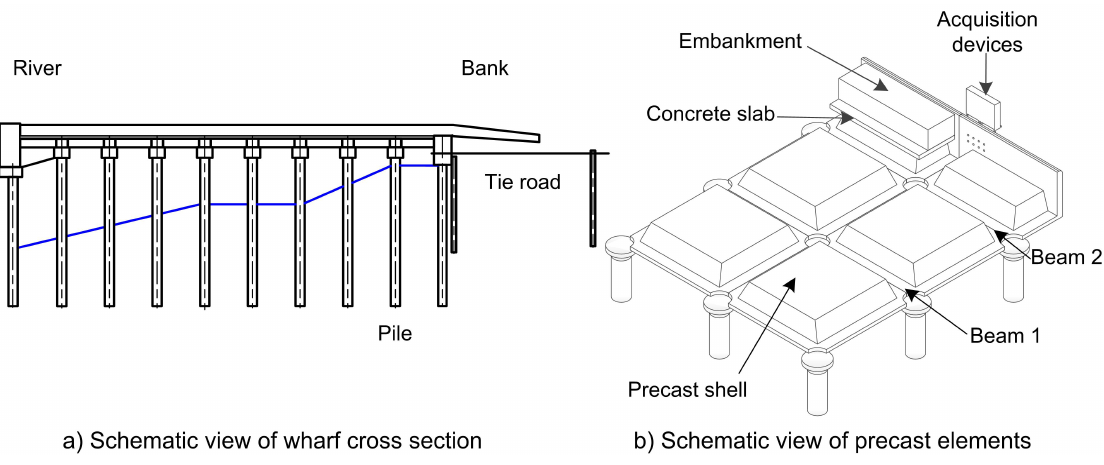
Figure 1. Schematic view of the wharf.